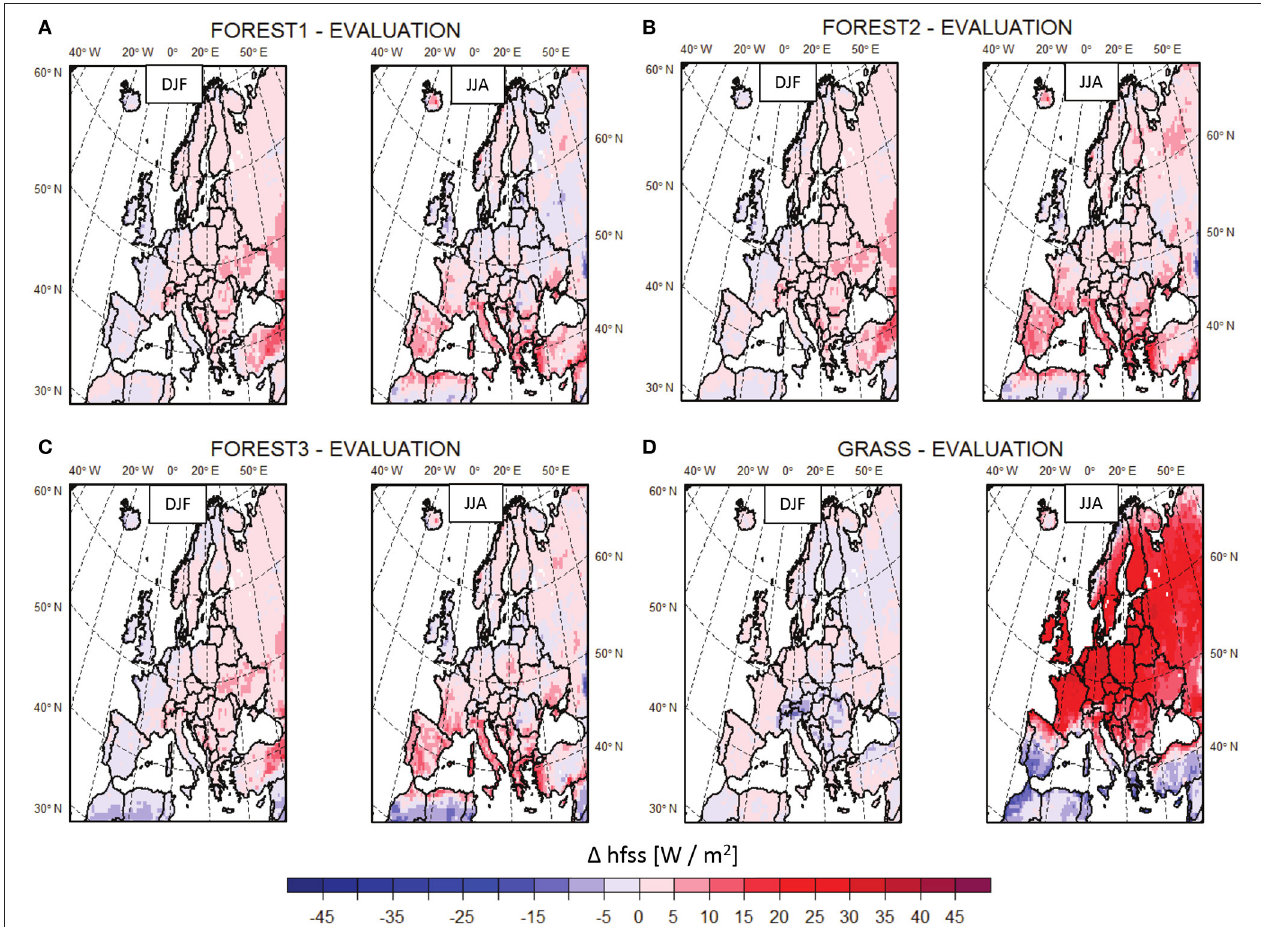
FIGURE 7 | Spatial distribution of mean sensible heat flux changes over the EURO-CORDEX domain for the conversion to forest with three different albedo parameterizations [FOREST1 (A) , FOREST2 (B) , FOREST3 (C) ], and to grassland [GRASS (D) ] for winter (DJF, left) and summer (JJA, right) for 1986–2015. The difference between experiments and the EVALUATION simulation with no land cover change is displayed over land points